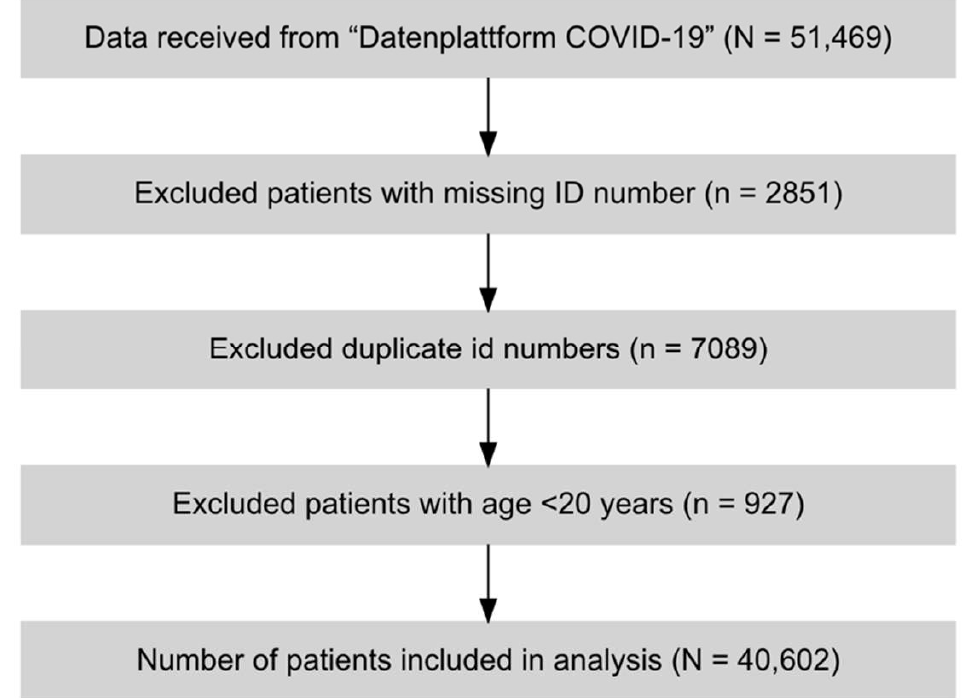
Figure 1. Flow diagram of extraction.